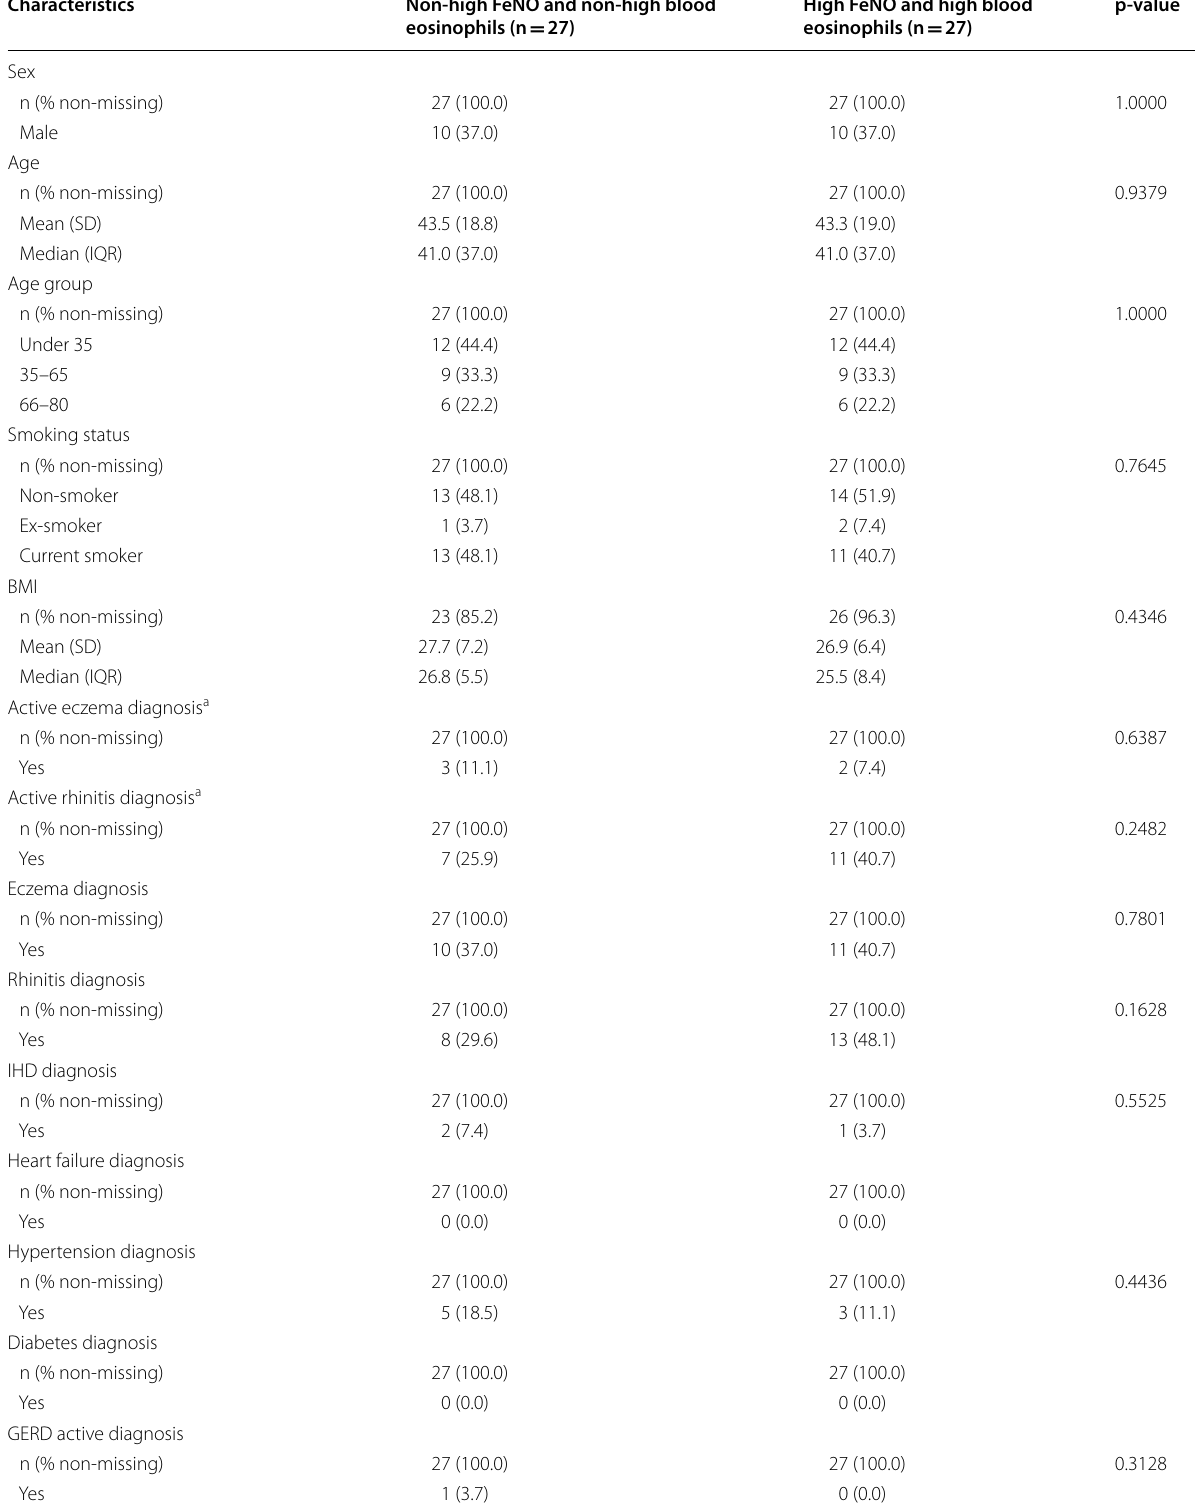
Table 1 Categorisation 1: non-high FeNO and non-high blood eosinophils vs. high FeNO and high blood eosinophils